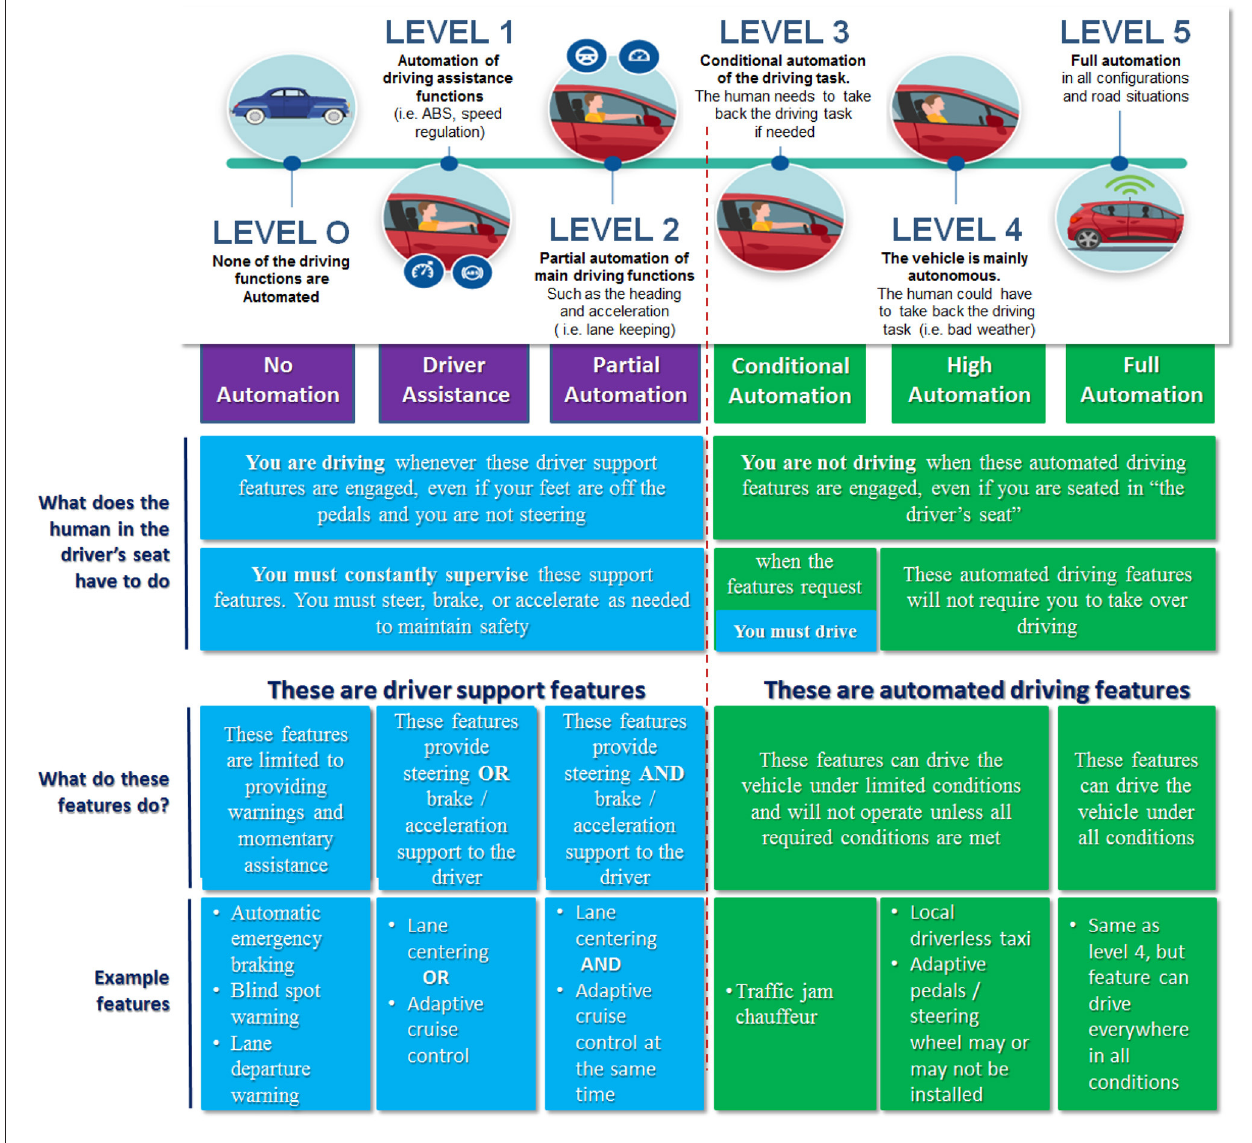
FIGURE 1 | Driving automation level as proposed by the